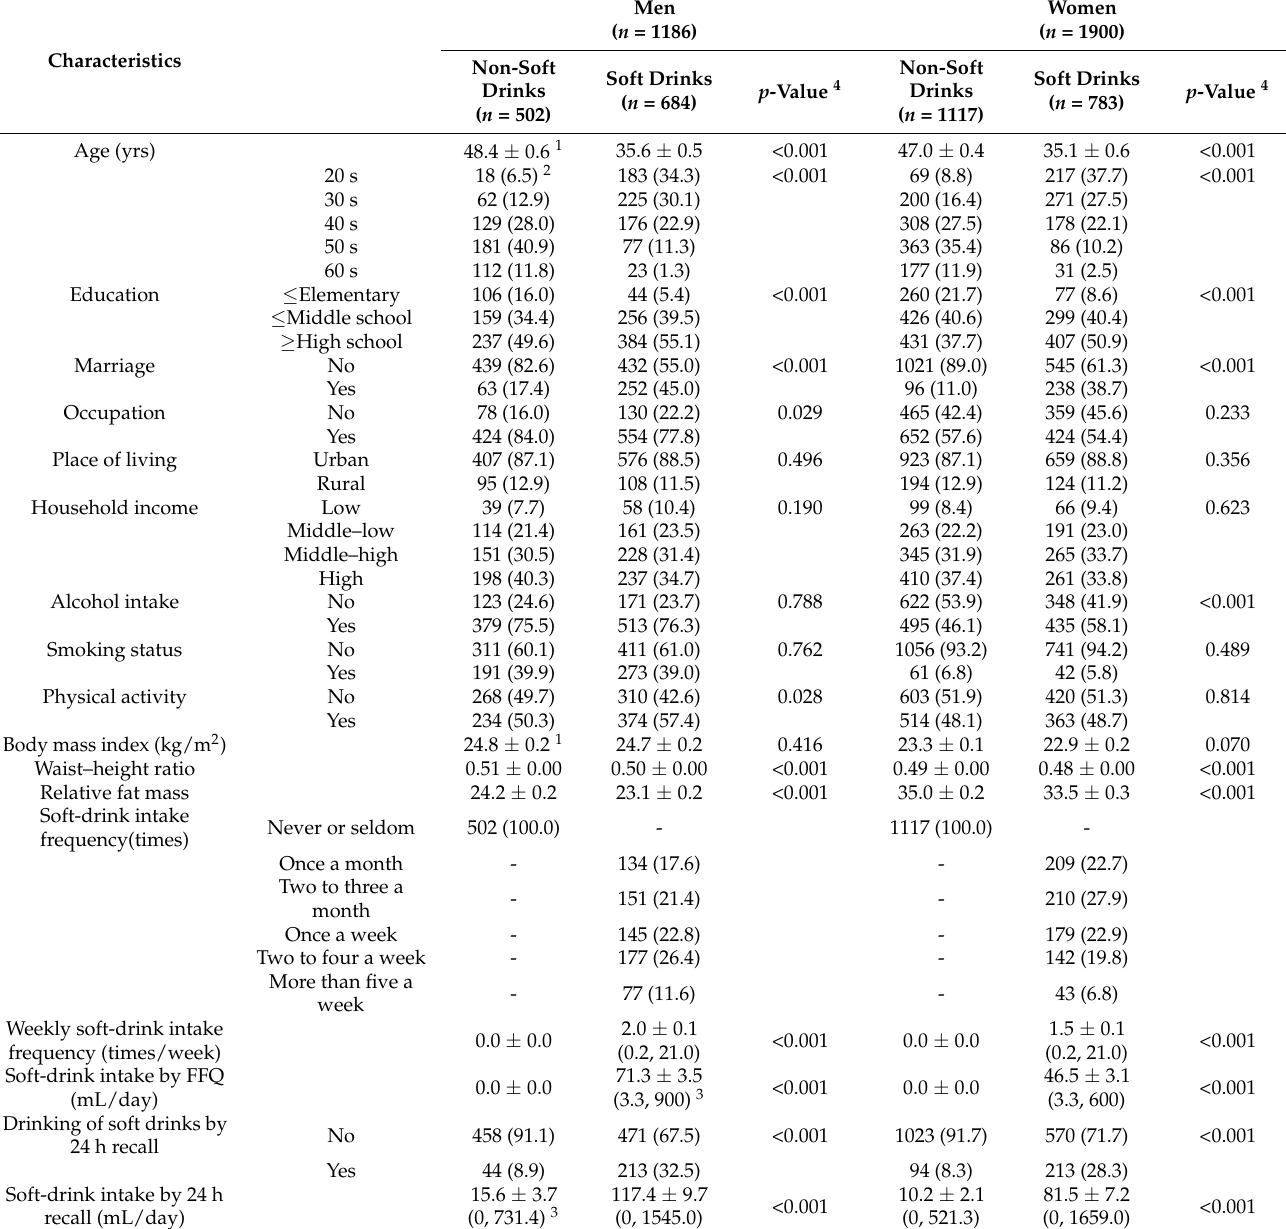
Table 1. Sociodemographic characteristics and soft-drink intake by participants according to soft-drink intake frequency by sex.